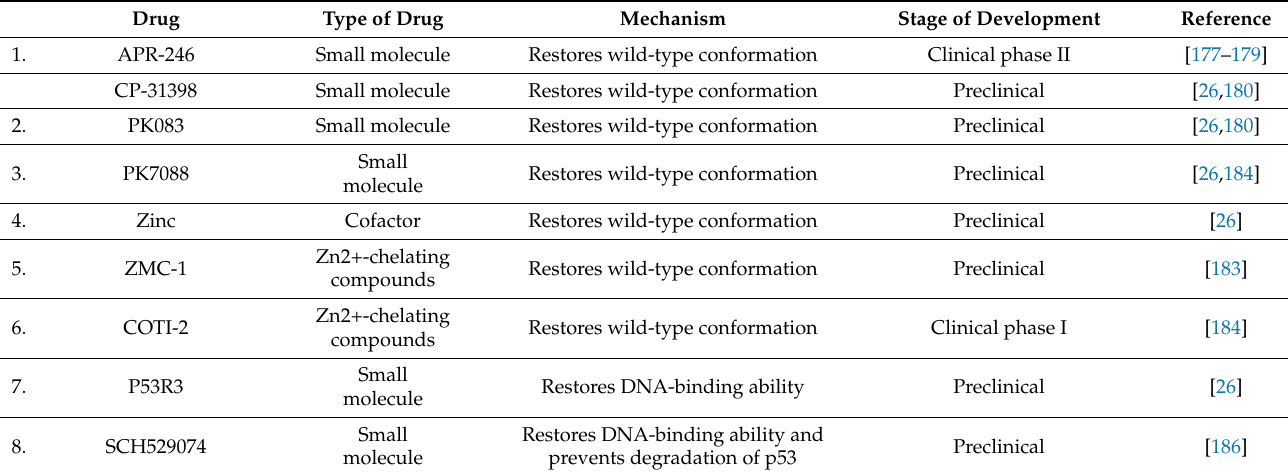
Table 1. List of drugs targeting p53 mutants in